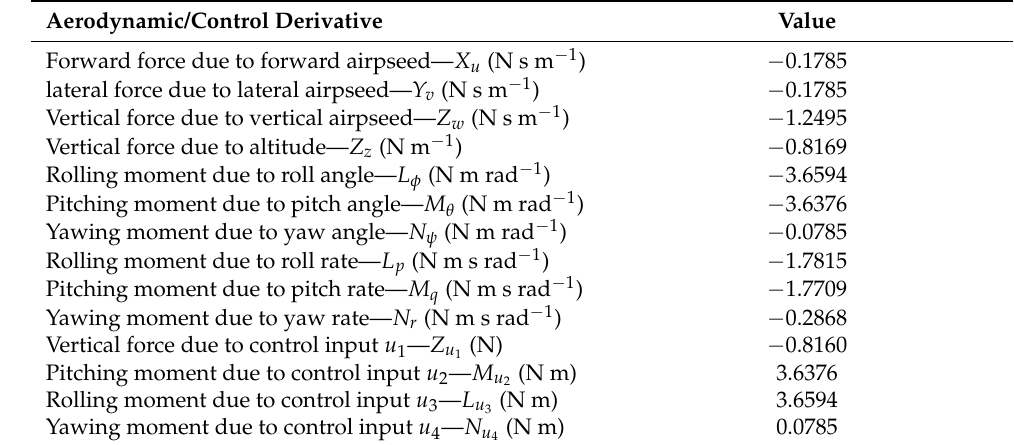
Table 2. Aerodynamic and control derivative values of the linear Draganflyer X-Pro model obtained through numerical